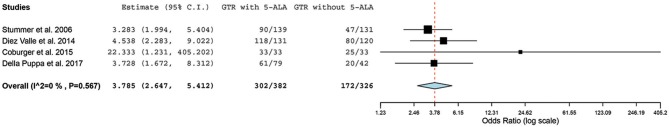
Forest plot graph representing the meta-analysis of the odd ratio (95% confidence interval [CI]) of gross total resection (GTR) among patients with primary high-grade gliomas treated using 5-aminolevulinic acid (5-ALA)–guided surgical resection vs. conventional microsurgical resection. Used with permission from Barrow Neurological Institute, Phoenix, Arizona.